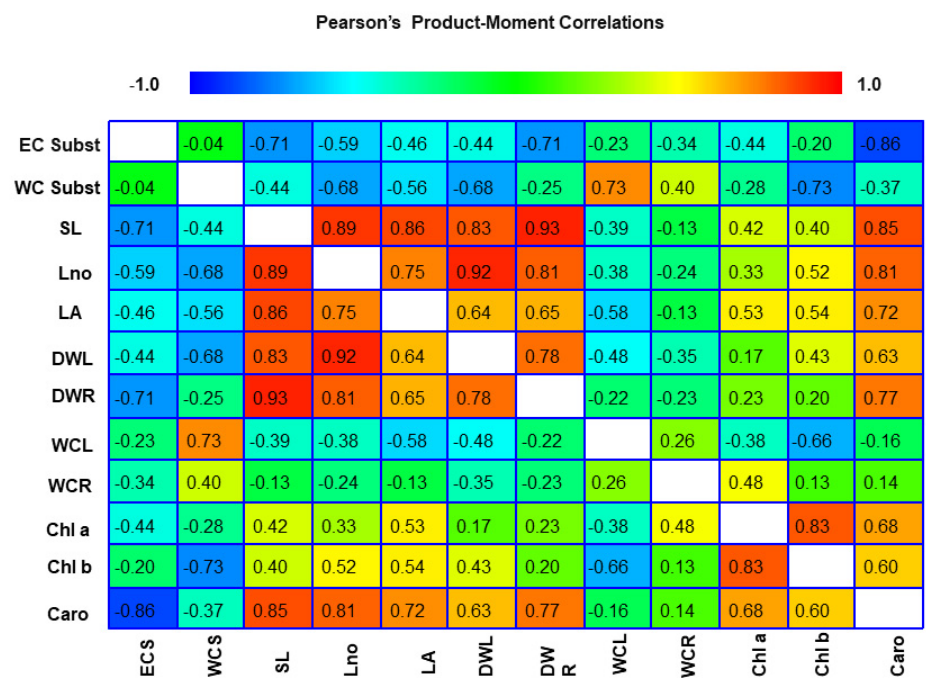
Figure 8. Pearson’s correlations between electrical conductivity of the substrate (EC subst), substrate water content (EC subst), stem length (SL), number of leaves (Lno), leaf area (LA), fresh weight of leaves (FWL) and roots (FWR), water content of leaves (WCL) and roots (WCR), chlorophyll a (Chl a), chlorophyll b (Chl b) and carotenoids (Caro).